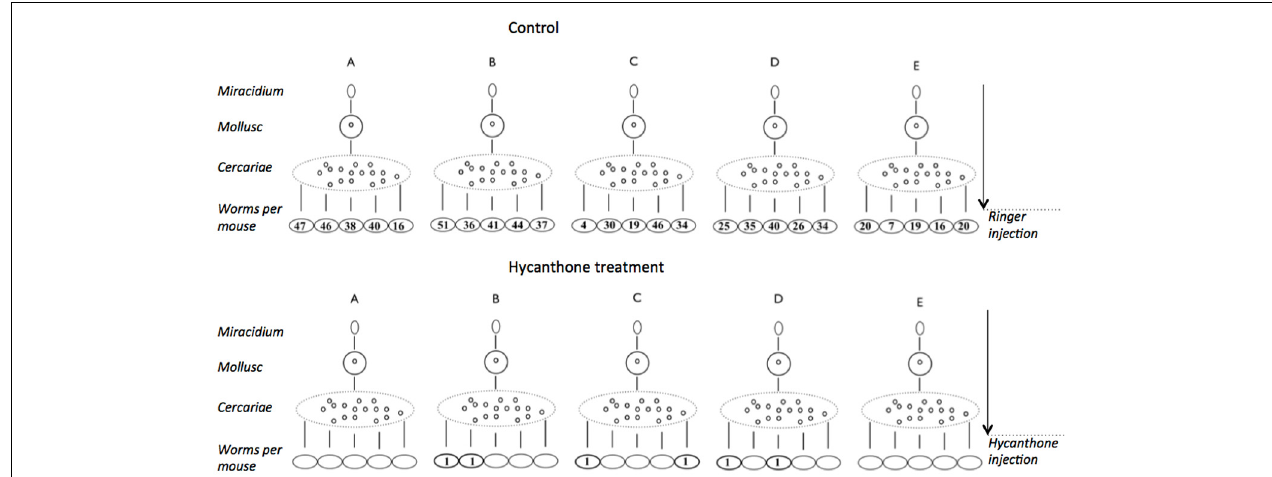
FIGURE 3 | Results of the experiment on induction of hycanthone resistance using mono-miracidial infections. Five mollusks were infected using a single miracidium (genotypes A–E). Cercariae shed from a single mollusk are clonal and were used to infect 10 mice. Half of the mice were injected with a control Ringer’s solution and